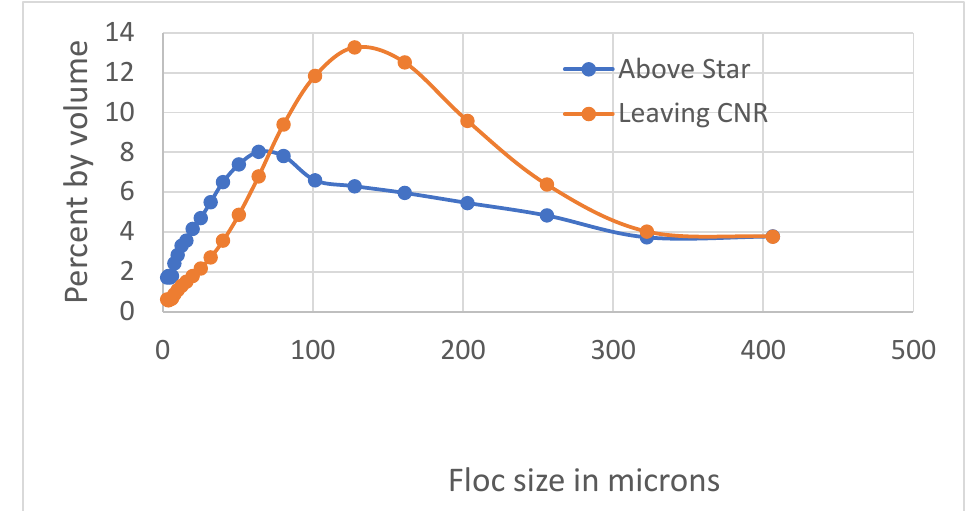
Figure 13. Comparison of effective particle size distributions of sediment entering and leaving the Crowsnest River reach.